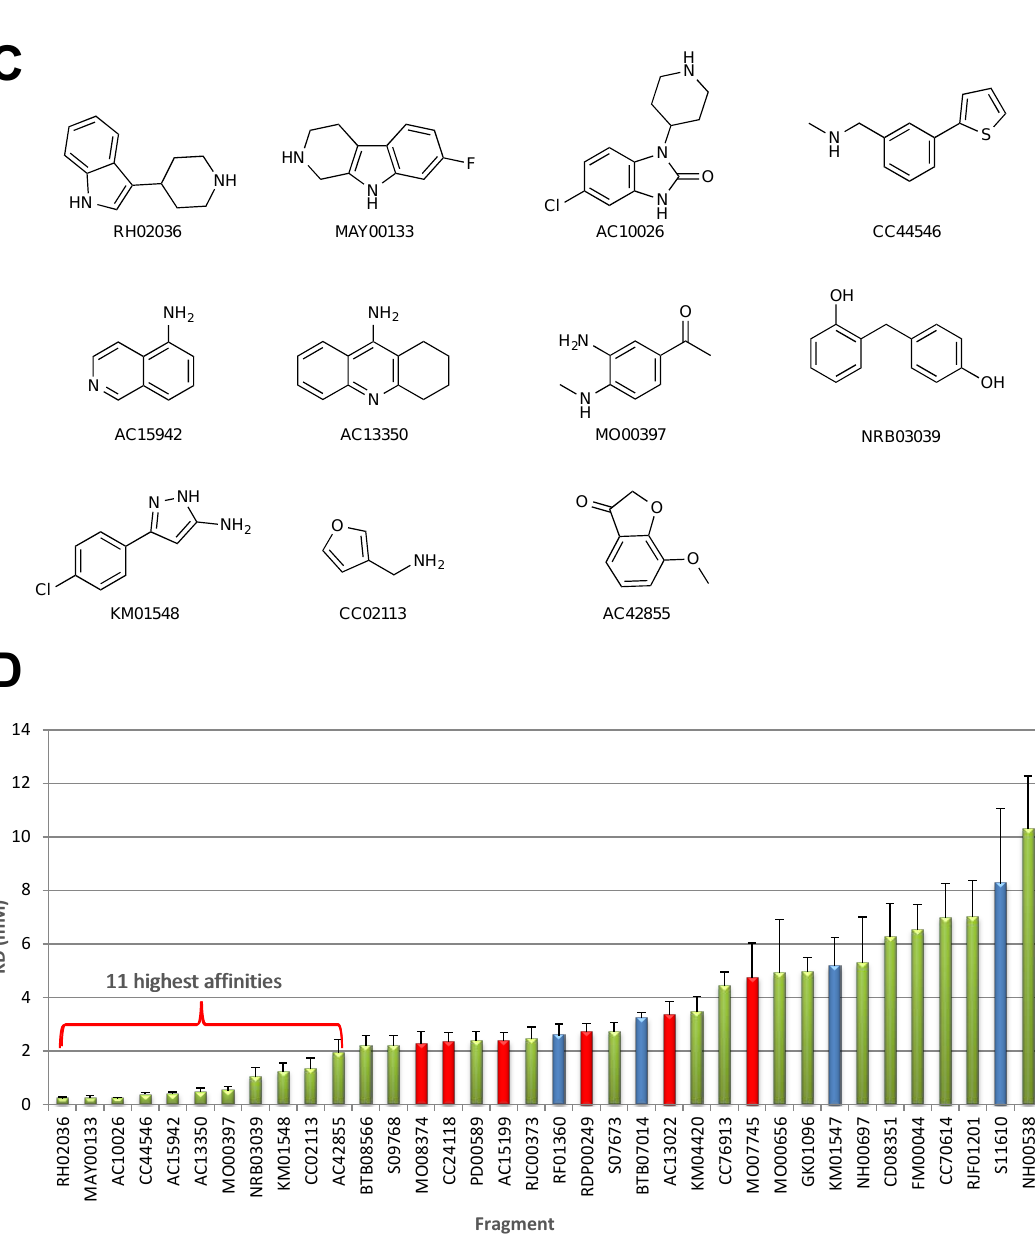
Figure 3. Validated fragment hits from the SPR screen. ( A) Structures of the top 11 fragments that bind with the highest affinity to EBNA1. ( B ) Bar graph showing the binding affinities of the top EBNA1 fragments. Green bars are SPR-only fragment hits. Red bars are overlapping hits from the STD–NMR screen. Blue bars are initial hits from the STD–NMR screen that were not subsequently validated. Error bars (fitting error) show assay robustness, typically approximately, or below, 25% variation. ( C ) Structures of the top 11 fragments that bind with the highest affinity to LANA. ( D ) Bar graph showing the binding affinities of the top EBNA1 fragments. Colors and error bars are as described in ( B)